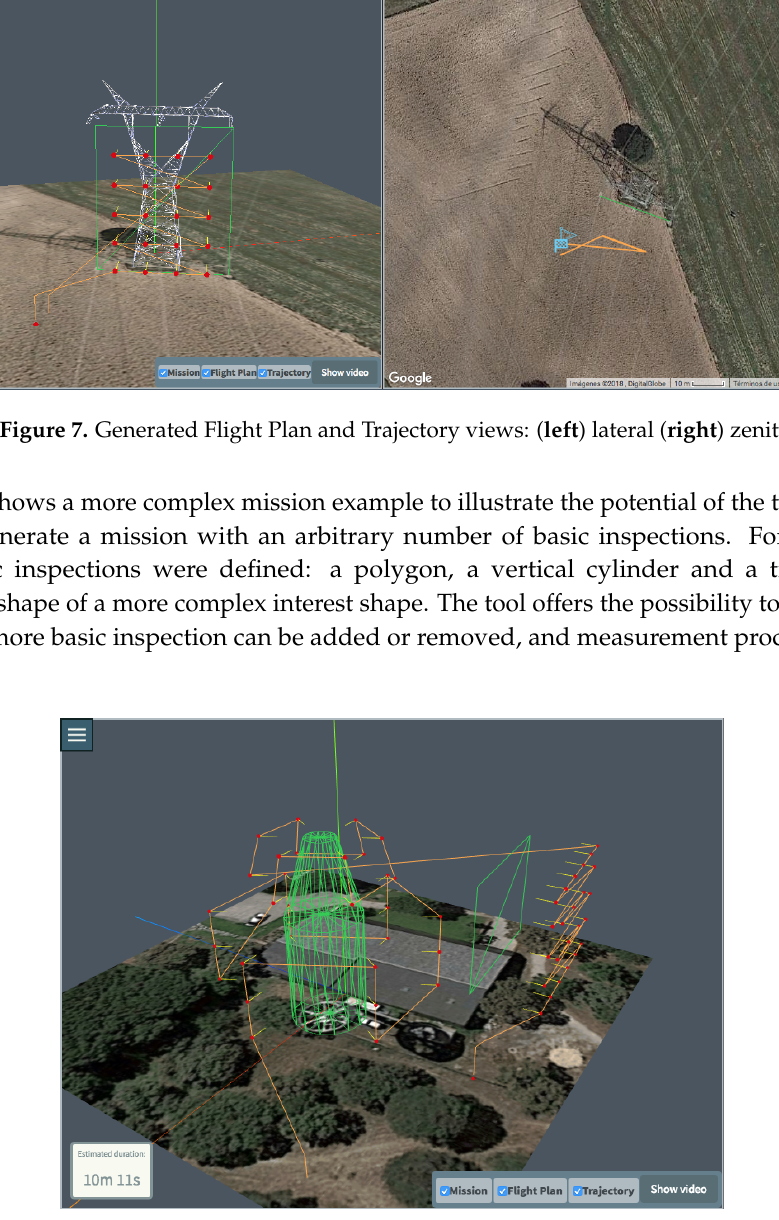
Figure 8. A more complex mission with multiple